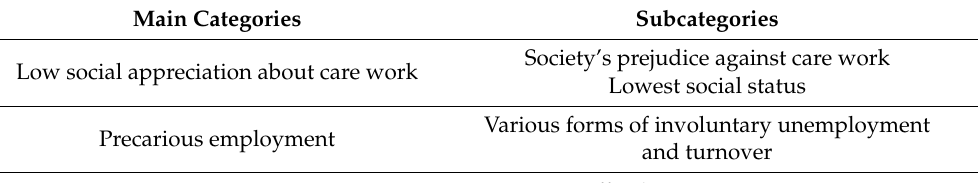
Table 2. Characteristics of elderly care work that influence turnover intentions of care